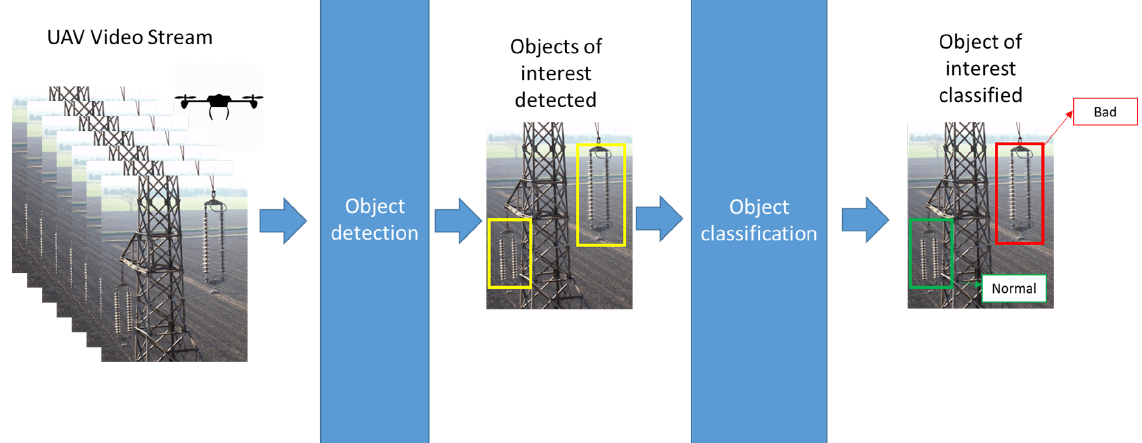
Figure 3. The scheme of the object detection and classification pipeline, applied to